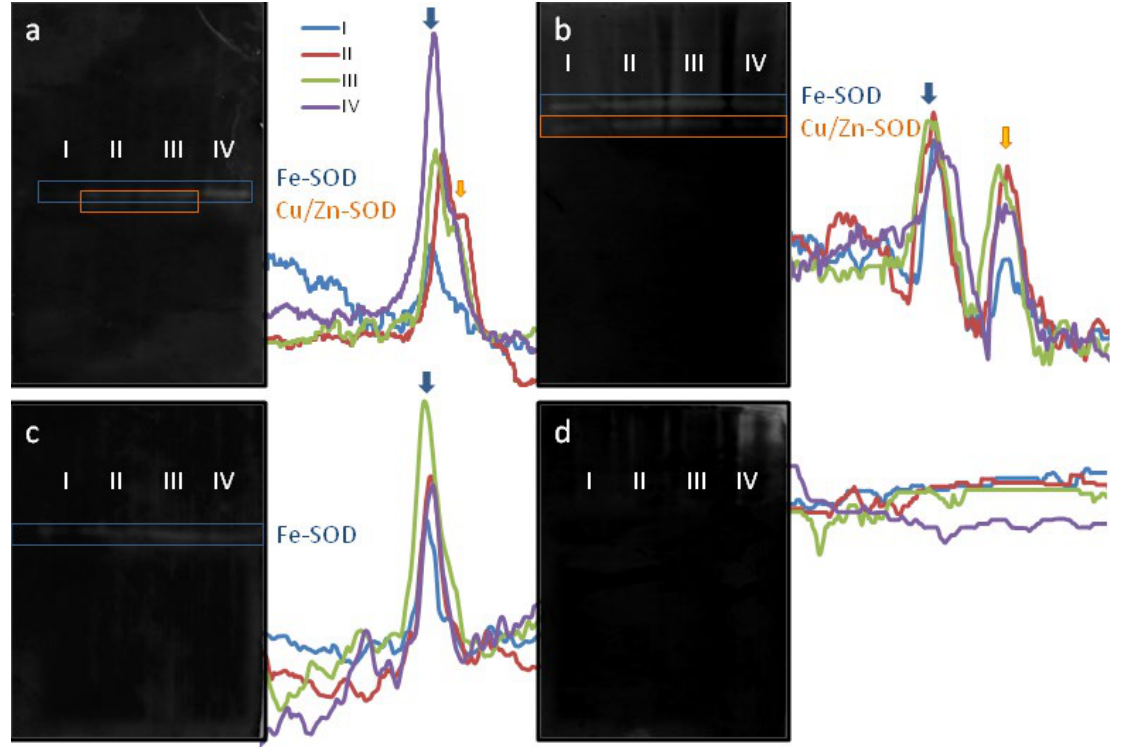
Figure 2. Zymographic detection of superoxide dismutase (SOD activity) and identification of isoenzymes in tobacco stigma. Total protein extracts from fresh stigmas of flowers were loaded into adjacent lanes. Prior to loading, protein concentrations in all extracts were determined by Bradford to adjust the application dose. After native PAGE, the following treatments were conducted, and then gels were stained with NBT reduction: ( a ) no treatment, 10% gel; ( b ) no treatment, 15% gel; ( c ) 3 mM KCN, 10% gel; ( d ) 5 mM H 2 O 2 , 15% gel. Optical density profiles are shown next to the gel. Both gels show that the activity of SOD at the first stage is lower than at subsequent ones, and the second isozyme is practically not detected in juvenile flowers (Figure